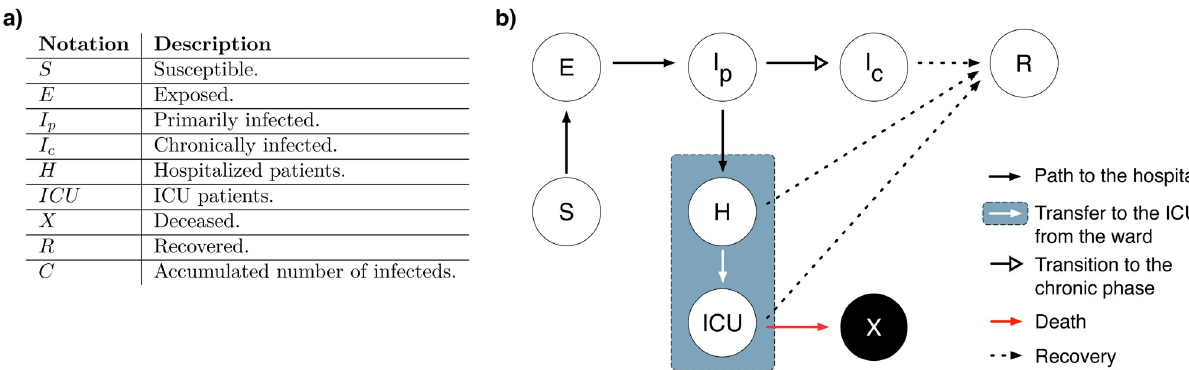
Fig 1. Illustration of the generalized SEIR model. a) Notation of the compartments and their corresponding descriptions. b) Schematic of the dynamical model given by Eq set